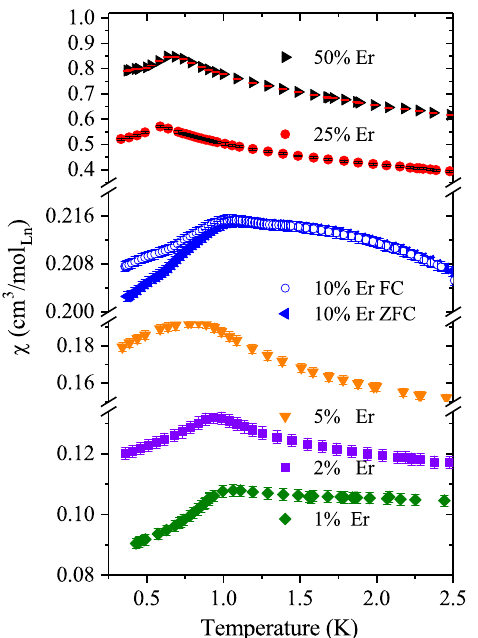
Figure 7. Low-temperature DC-magnetic susceptibility as a function of temperature for all samples at